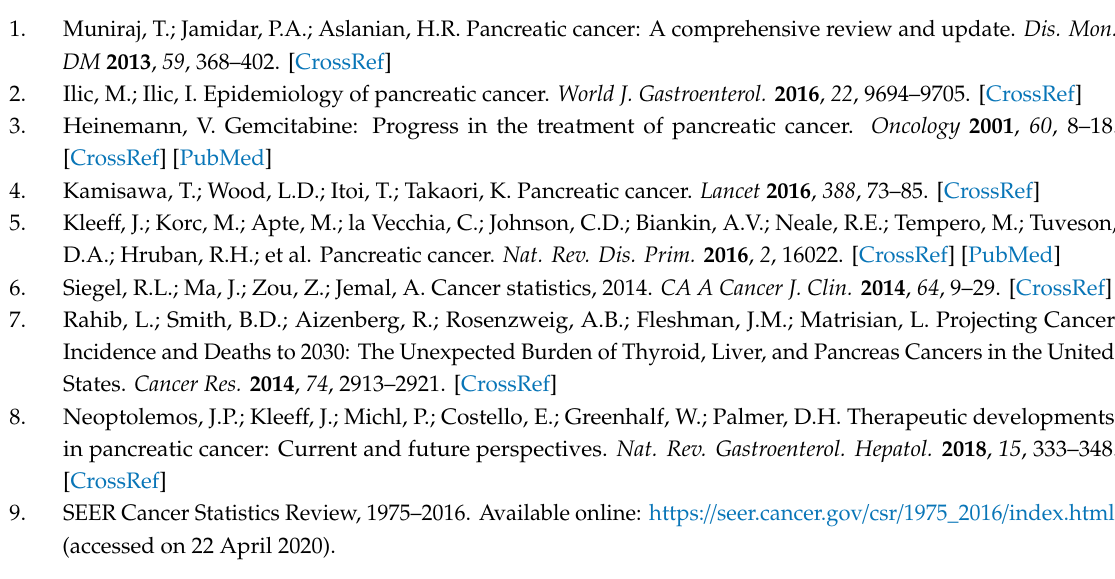
Figure S1: Mutation allele frequencies of KRAS, Table S1: Primer sequences used in this study, Table S2: Antibodies used in this study, Table S3: Results of endometabolic profiling, Table S4: Results of exometabolic profiling. Author Contributions: All authors have read and agree to the published version of the